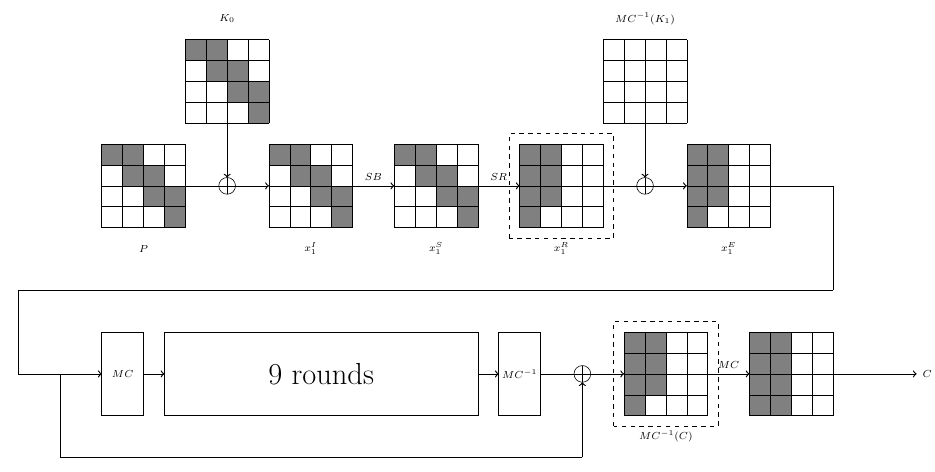
Figure 17: Zero-correlation attack for AES-PRF 1 , 9